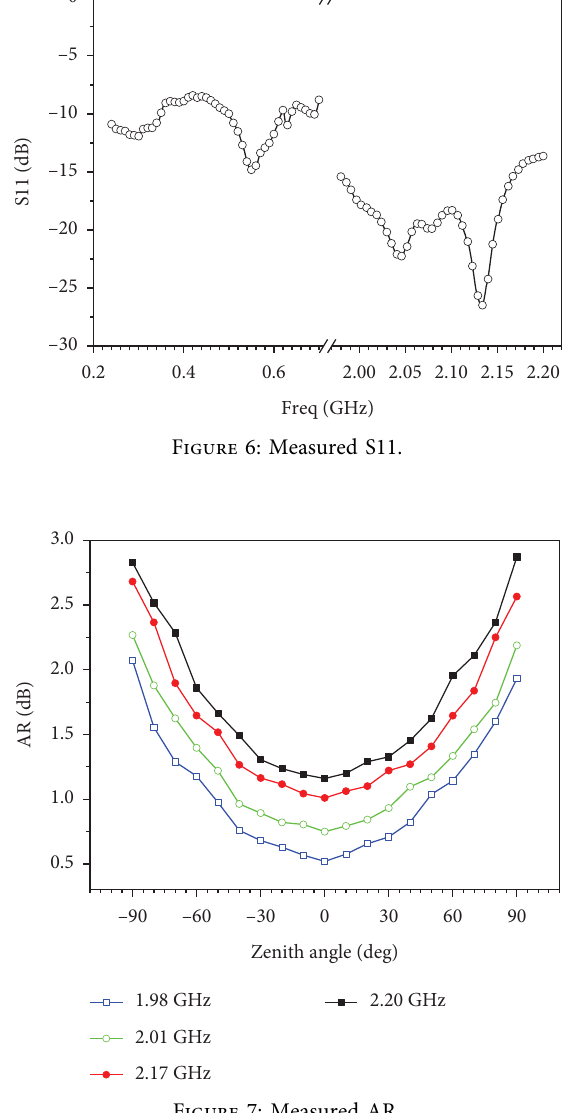
Figure 7: Measured